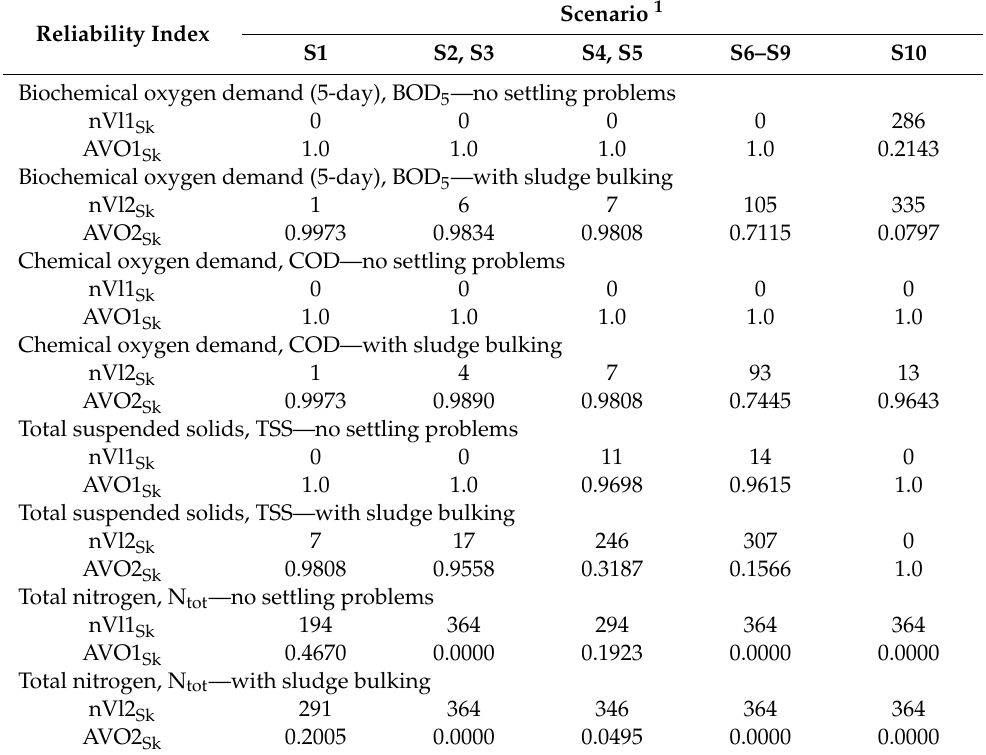
Table 4. Simulation results for defined scenarios of activated sludge (AS) plant operation (flow proportional averages, N = 364